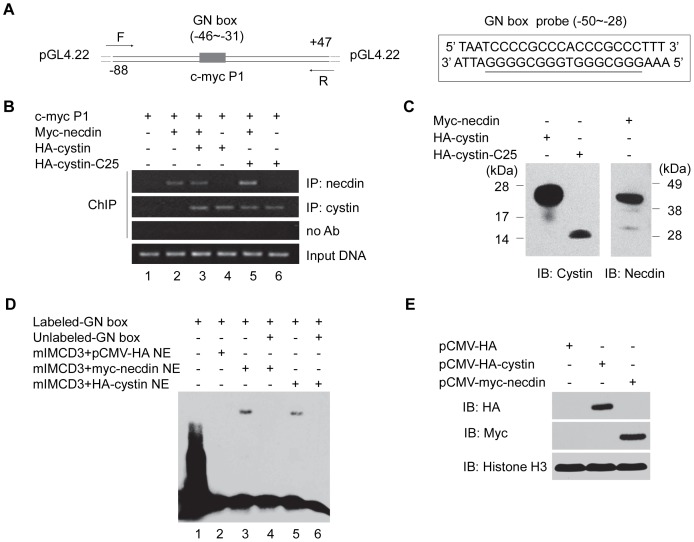
Both necdin and cystin bind to Myc P1 promoter DNA.(A) Schematic representation of the Myc P1 promoter (–88 ∼ +47) fragment in the pGL4.22 luciferase vector used for chromatin immunoprecipitation (ChIP). The ChIP primers (F and R) spanned the promoter region. The right panel showes the 23-bp EMSA probe, containing the Myc P1 GN-box (underlined). (B) ChIP was performed to identify the interaction of necdin, cystin, and cystin-C25 with the Myc P1 promoter fragment. After sonication, the protein-DNA complexes were immunoprecipitated either with the anti-necdin (N143) or cystin (70053) antibody. (C) Western blot analysis confirmed that each of the constructs were highly expressed in the ChIP experiments. HA-cystin/HA-cystin-C25 were detected with the anti-cystin antibodies (70053) and myc-necdin was detected with an anti-necdin antibody (N143). (D) EMSA was performed to analyze the binding of necdin and cystin to the Myc P1 DNA fragment. The biotin-labeled probe (A right panel) containing the Myc P1 GN box was incubated with nuclear extracts from mIMCD-3 cells transfected with wild-type cystin and necdin. Both cystin and necdin bound to the Myc P1 GN box (lanes 3, 5) and this binding was efficiently abolished by unlabeled probe. (E) Immunoblotting analysis of the EMSA samples indicated robust expression of HA-cystin and myc-necdin in nuclear extracts, histone H3 was used as a loading control.